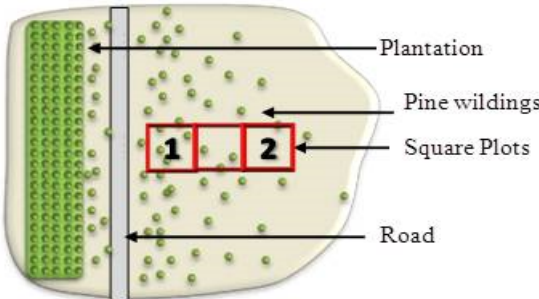
Figure 2. Location and design of the sampling plots in the study site. Each square plot (20 by 20 m) is subdivided in a grid of 0.25 m (0.0625 m 2 ) quadrats.